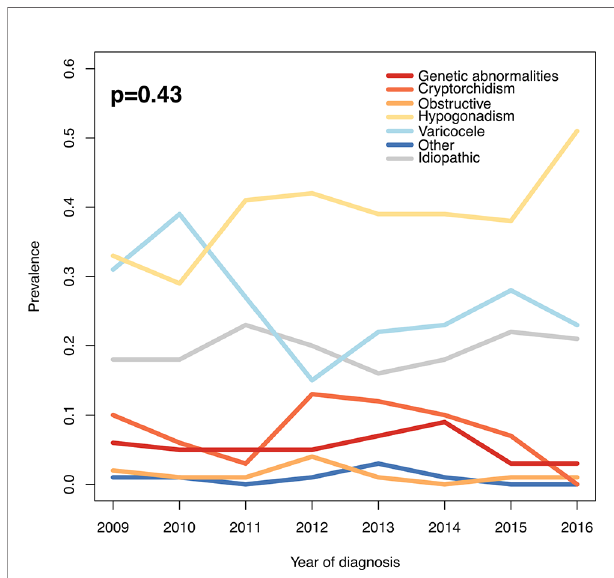
FIGURE 1 | Prevalence of different causes of male factor infertility during the study period. P-value as for Chi-square test.